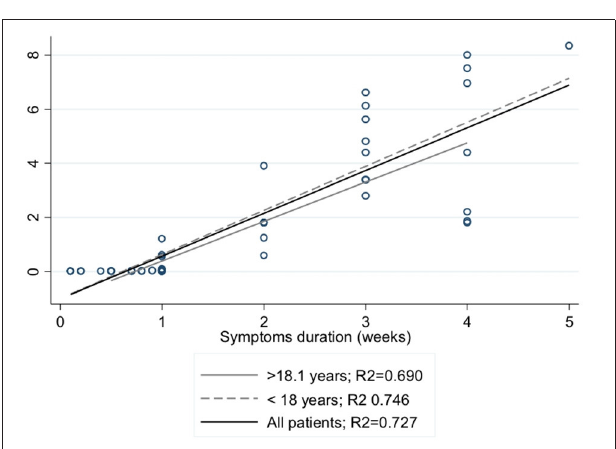
FIGURE 2 | Correlation between duration of symptoms and levels of IgG for SARS-CoV-2.